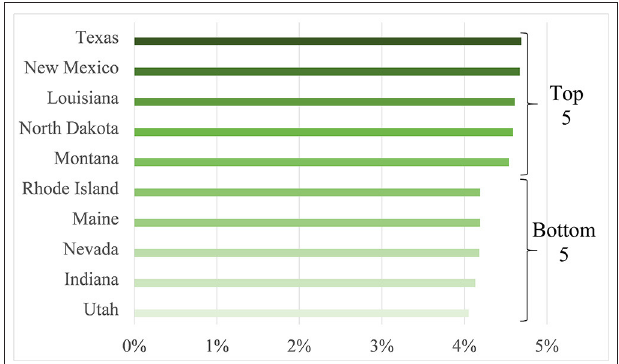
FIGURE 8 | Percent decrease in cow meat production compared to baseline production for the top five and bottom five states in